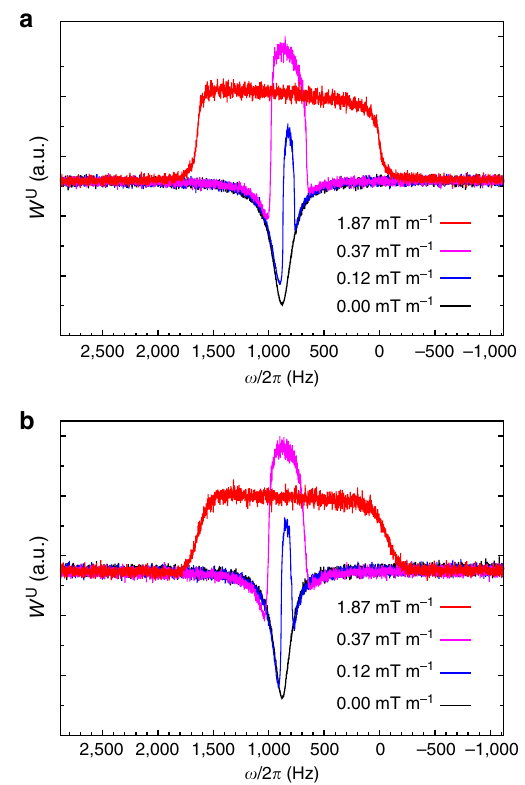
Figure 1 | Influence of gradients on spin-noise spectra. Simulated ( a ) and experimental ( b ) 700MHz 1 H spin-noise spectra acquired from a sample of 90% H 2 O:10% D 2 O with a z -gradient of 0.00 (black), 0.12 (blue), 0.37 (magenta) and 1.87mTm (cid:2) 1 (red). The sample height used in the simulations was 20mm, which corresponds approximately to that of the 1 H saddle coil, while the true filling height in the round bottomed 5mm o.d. sample tubes was 34mm. The simulations corresponding to the experimental spectra were done using a Scilab programme 32 based on equation (5). The best-fit values extracted from the spectra of Fig. 3 were used for electronic parameters and radiation damping rate. A transverse relaxation rate of 2Hz was assumed and the sample was split in 33 of less than perfect field homogeneity. These artifact peaks can be of advantage as indicators of insufficient field inhomogeneity as a necessary condition for their appearance is D n grad \ l 2 . In addition, they can provide the precise chemical shift of the major isotope peak in the radiation-damped spectra when determining isotope effects as described below.